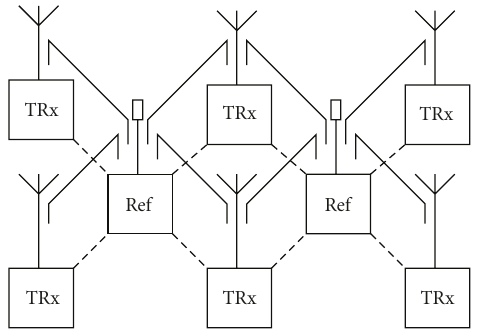
Figure 4: A pair of reference elements, used to calibrate a 2 × 3 array.